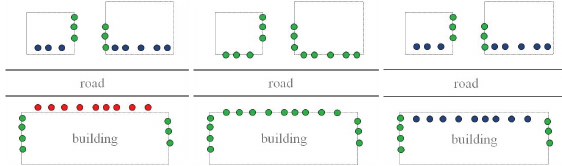
Figure 4. Illustration of absolute and relative accuracy: absolute accuracy low across street (left), absolute and relative accuracy high (middle), relative accuracy low